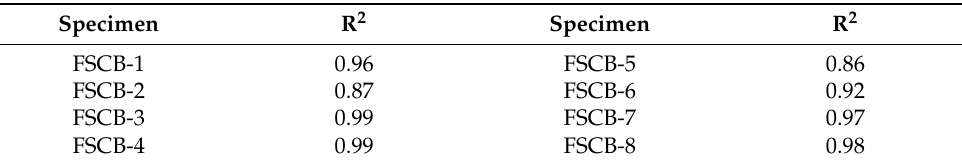
Table 7. Fitting accuracy of Equation (4).